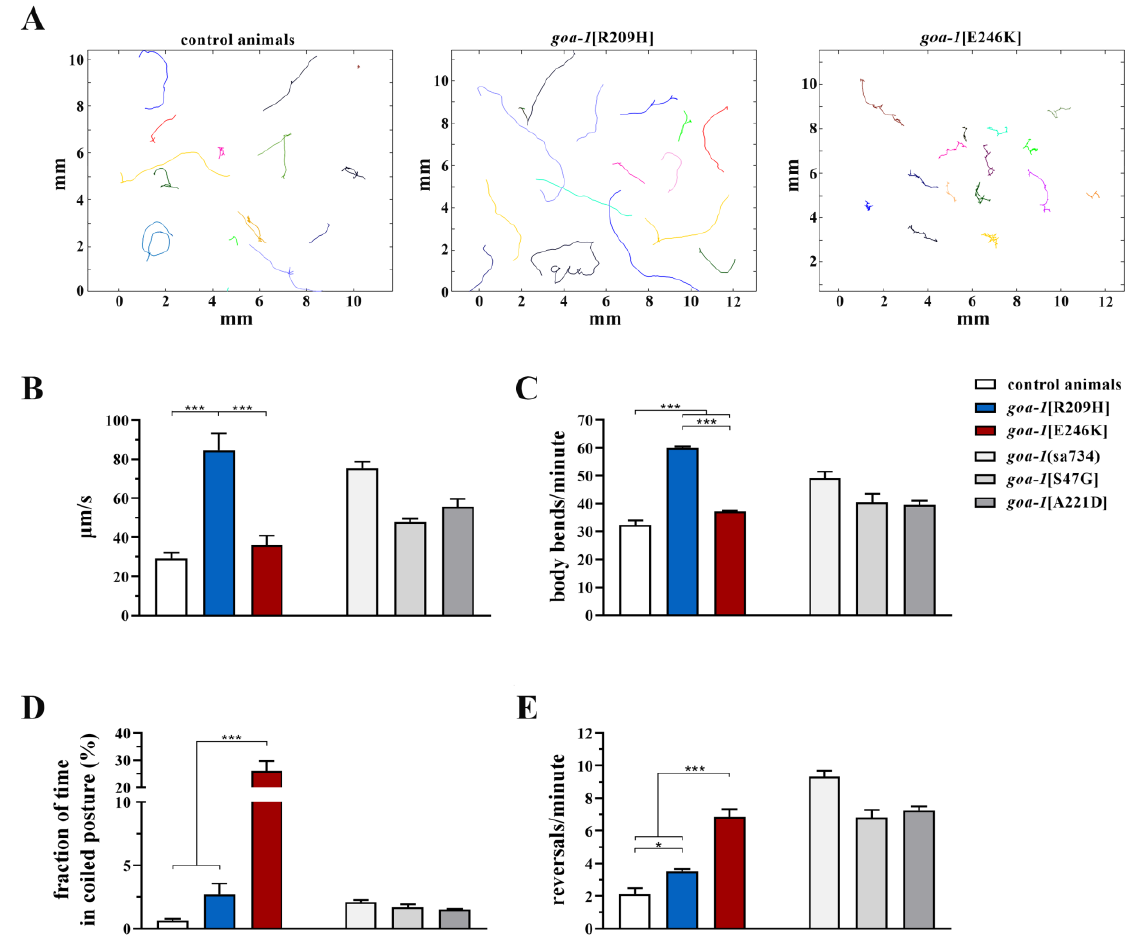
Figure 2. goa-1 [R209H] and goa-1 [E246K] animals exhibit aberrant motor behavior. ( A ) Trajectories of 15 worms on agar plates recorded for 2 minutes. Different colors refer to different animals. The gene-edited mutants showed abnormal crawling and longer ( goa-1 [R209H]) or irregular ( goa-1 [E246K]) tracks compared with the controls. ( B ) goa-1 [R209H] crawled faster than wild-type animals ( *** p < 0.0001; one-way ANOVA with Bonferroni correction). The aberrant motor behavior of both mutants was also revealed by the number of body bends per minute ( C ), the time spent in a coiled position ( D ), and the reversal rate ( E ) (* p < 0.05 and *** p < 0.0001). Twenty animals were tested for each genotype. Data represent means ± SEM of multiple observations. Data collected in our previous study [18] are included in panels B–E for comparison (gray bars). sa734 is a null allele of goa-1